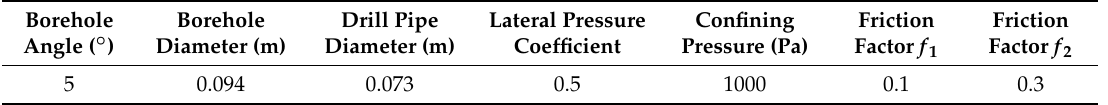
Table 1. The parameters of the drilling